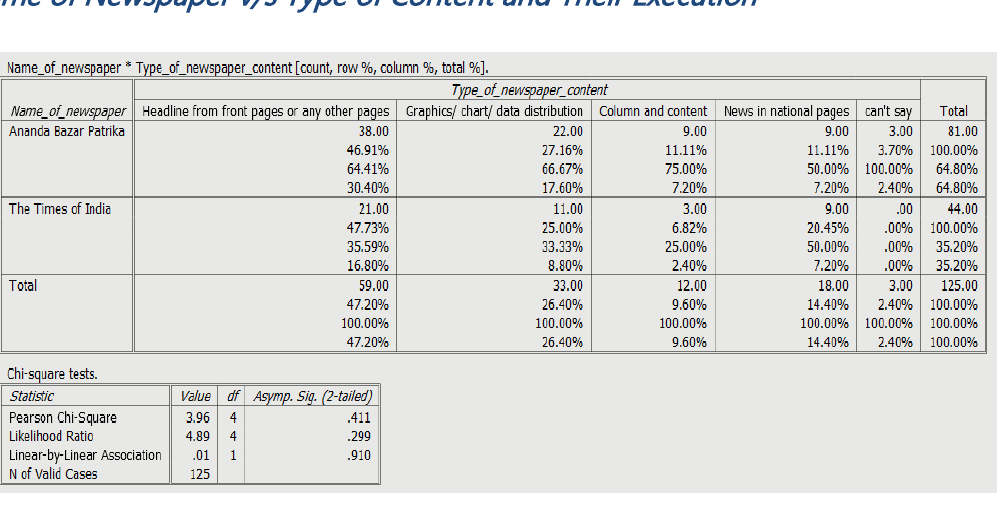
Figure 10: Cross Tabulation and Chi-square between Newspaper V/S Newspaper Content (Source: Authors‟